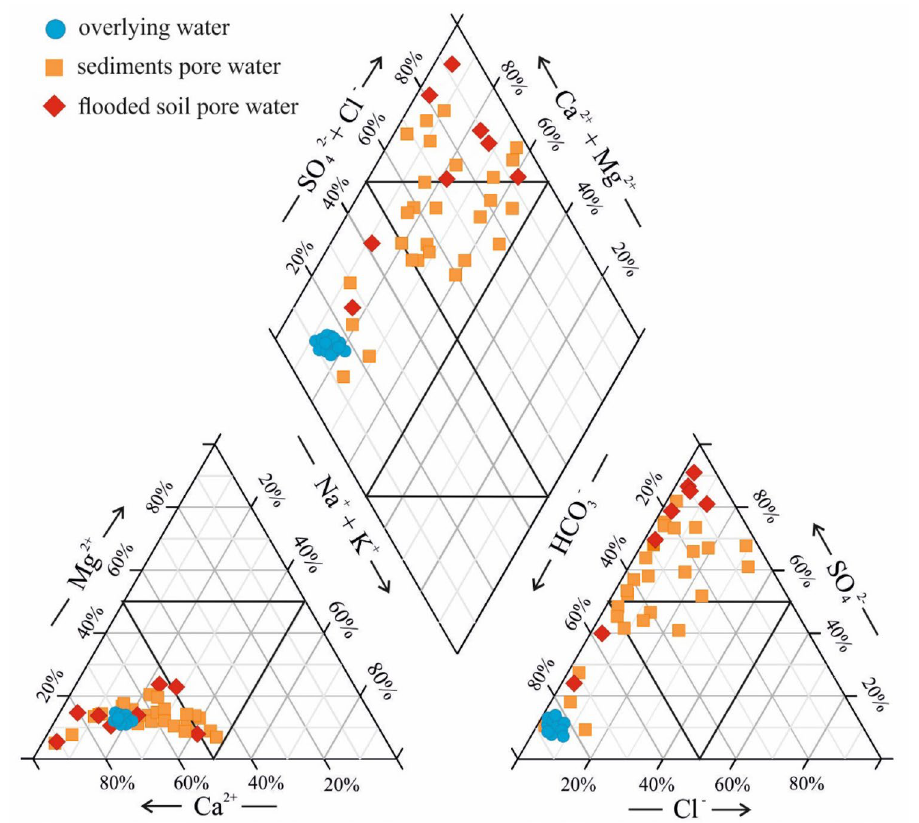
Figure 2. Piper diagram of reservoir pore water and overlying water. Figure was created using Grapher (17.2.435, www. golde nsoft ware. com) and CorelDRAW (21.3.0.755, www. corel.